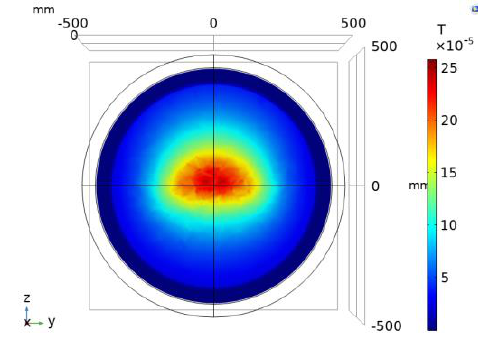
Figure 17. Square coil with a plane core on the primary side.